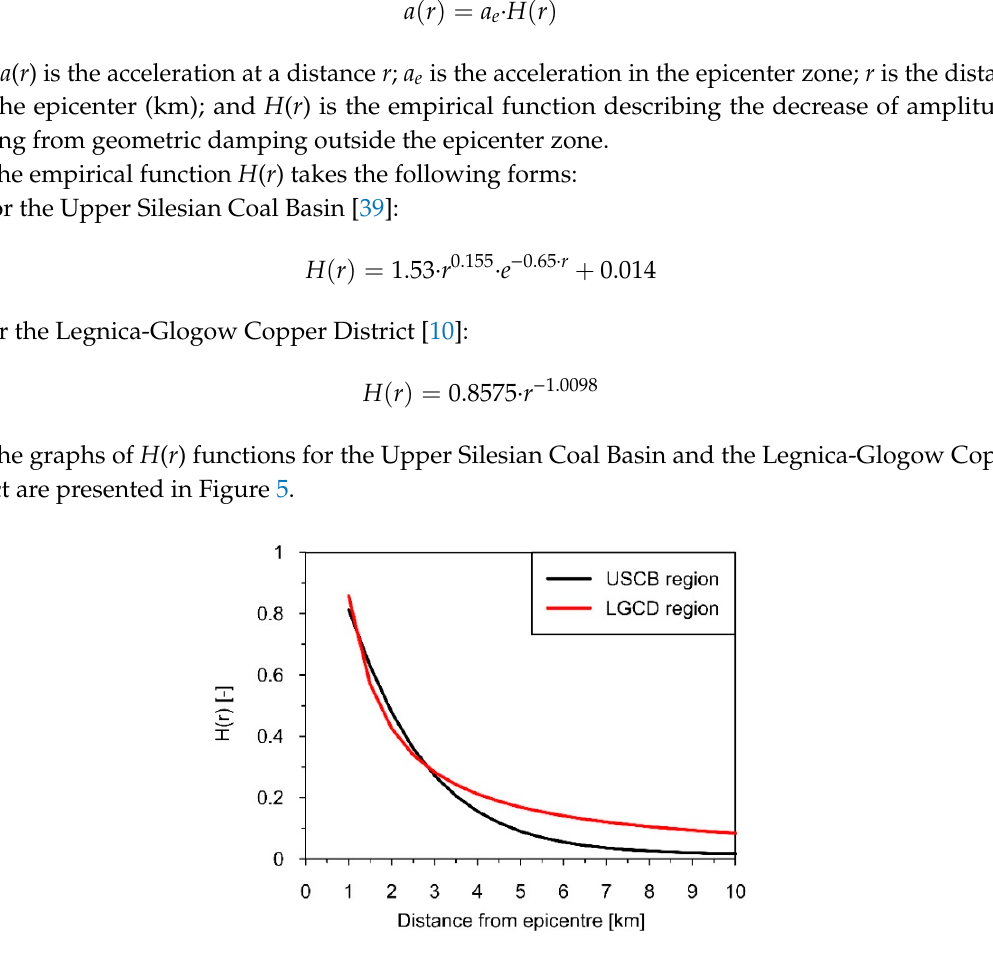
Figure 5. The empirical functions H ( r ) adopted in the determination of the reduction of vibration amplitudes with the distance from the epicenter.